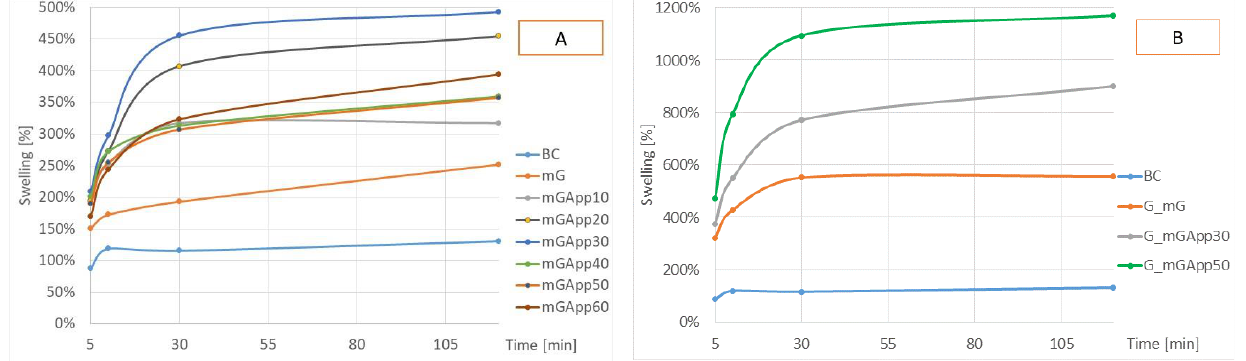
Figure 5. The swelling capacities of materials: bacterial cellulose (BC); bacterial cellulose pre-treated and modified with glycerol (mG and G_mG); bacterial cellulose pre-treated and modified with glycerol and by entrapping apple powder (mGApp10; mGApp20; mGApp30; mGApp40; mGApp50; mGApp60; G_mGApp30; and G_mGApp50). ( A ) Bacterial cellulose produced in media without apple powder (mGApp10; mGApp20; mGApp30; mGApp40; mGApp50; and mGApp60); ( B ) bacterial cellulose produced in media with apple powder (G_mGApp30; G_mGApp50). All data are the average of 3